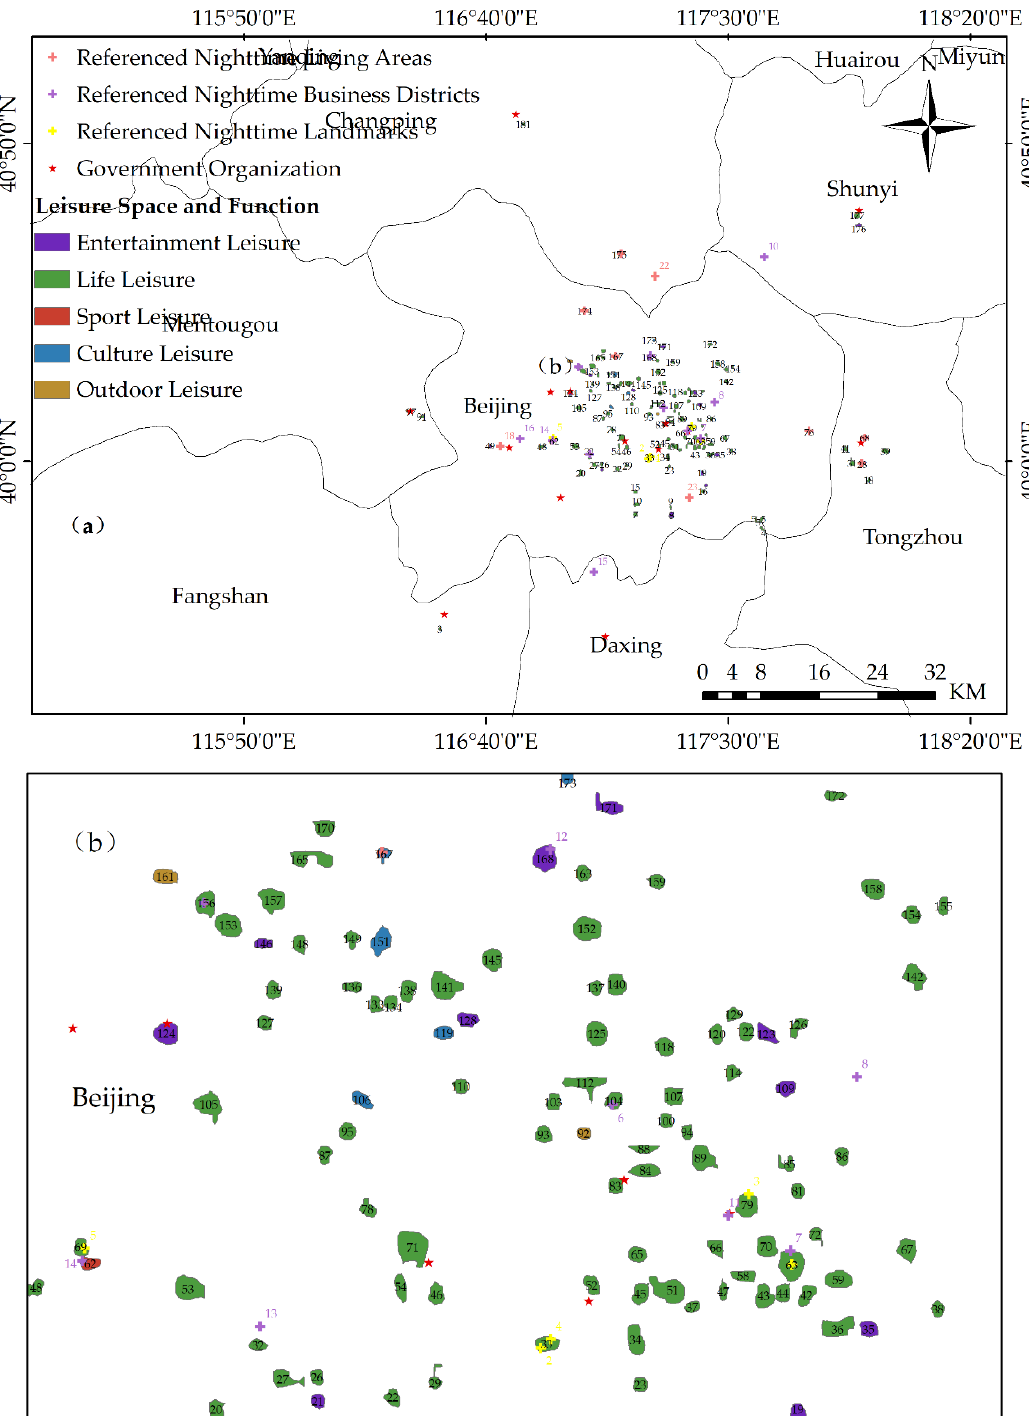
Figure 7. ( a ) Distribution of urban nighttime leisure spaces (UNLSs) in Beijing. ( b ) The main urban area is enlarged to show the details.